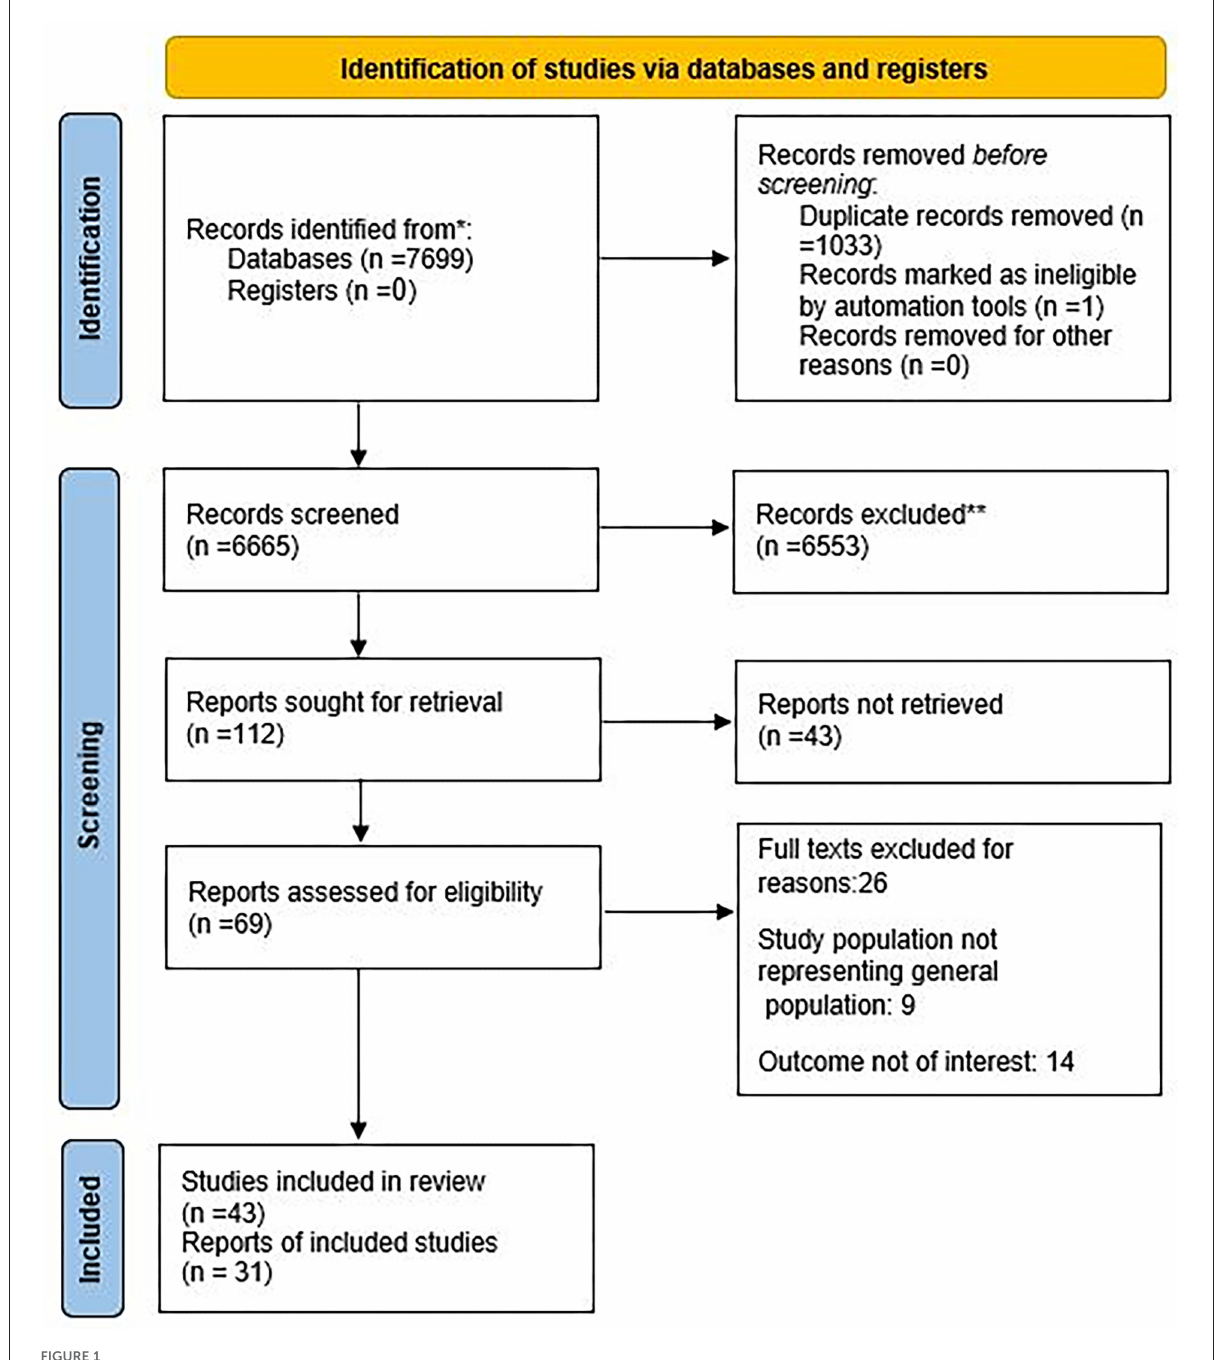
FIGURE1 The review flowchart for the selection of the primary studies.